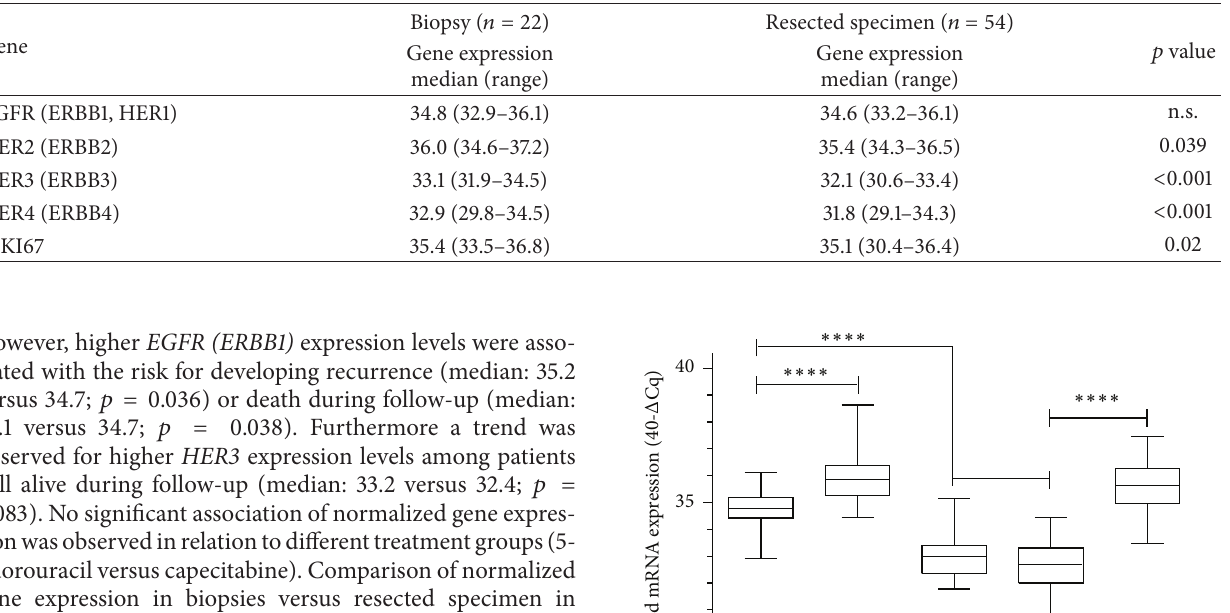
Table 3: Comparison of normalized gene expression values (40- Δ Cq) in biopsies versus resected specimen in the adjuvant treatment group. Significant lower expression in resected specimen was observed for HER2–HER4 and MKI67 (n.s.: not significant).